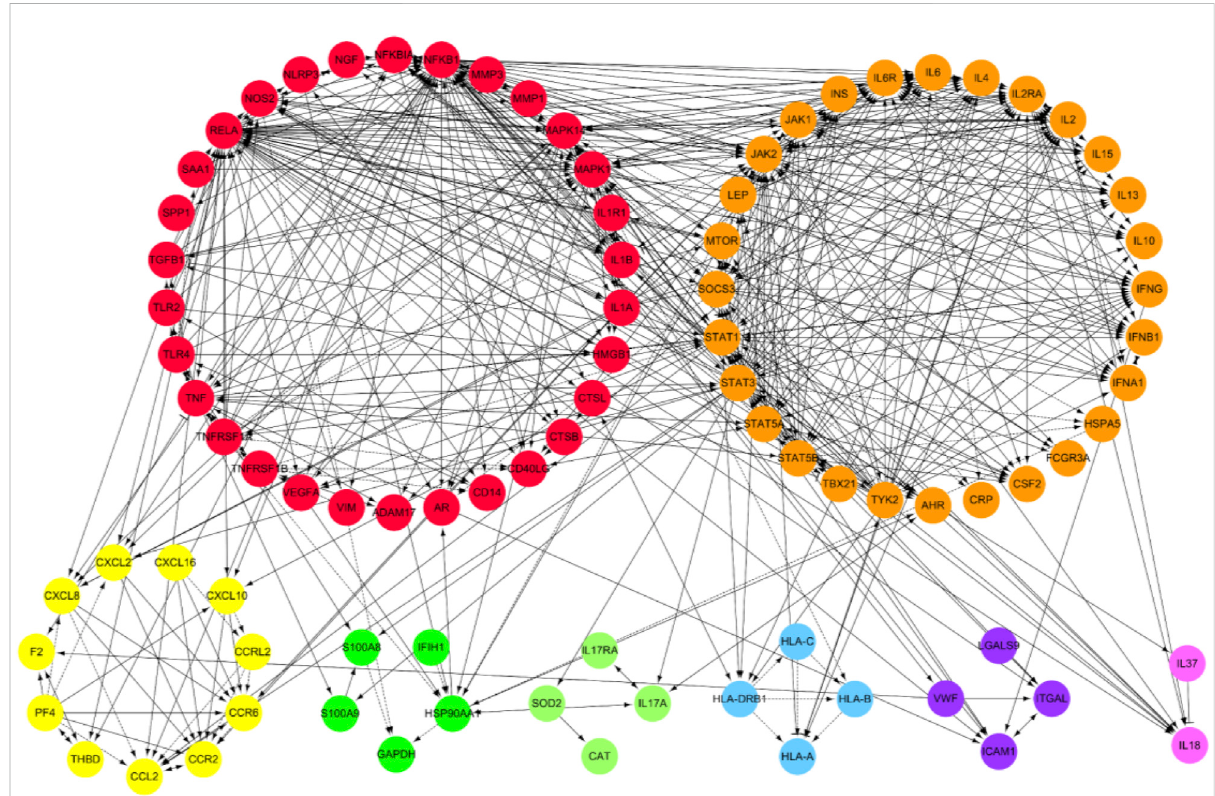
FIGURE 3 Module function analysis of common targets of multiple disease combinations (COVID-19, RA, AS, GA). After the functional analysis of the module,the99targetscanbeaggregatedintoeightmodules,andthecircleofeachcolorrepresentsonemodule,whichismainlyrelatedtoimmune response, in fl ammatory progression, bacteria and virus expression and other functions. And there is a close relationship between the enriched targets on each module, and also has a certain correlation with the targets on other